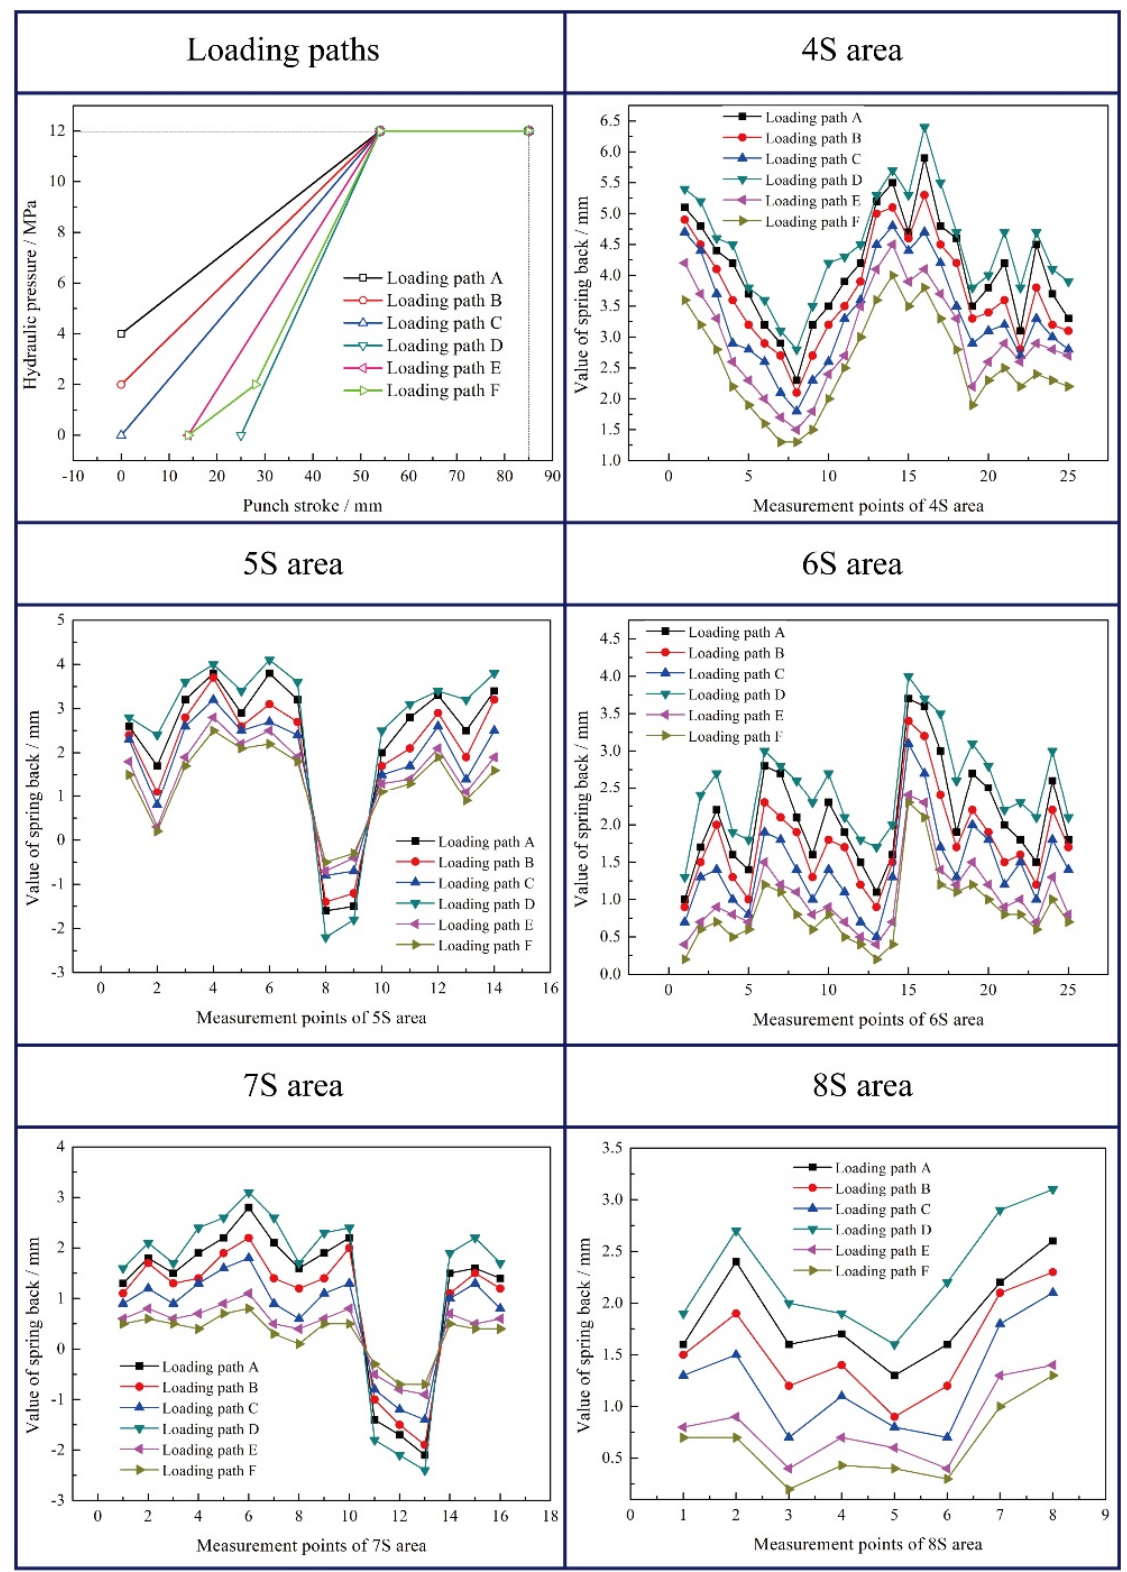
Figure 8. Initial hydraulic pressure paths and the corresponding spring back values of different areas. This figure is the spring back values of different areas (4S–8S areas) under different hydraulic pressure paths. The hydraulic pressure paths are in the first figure of Figure 8.